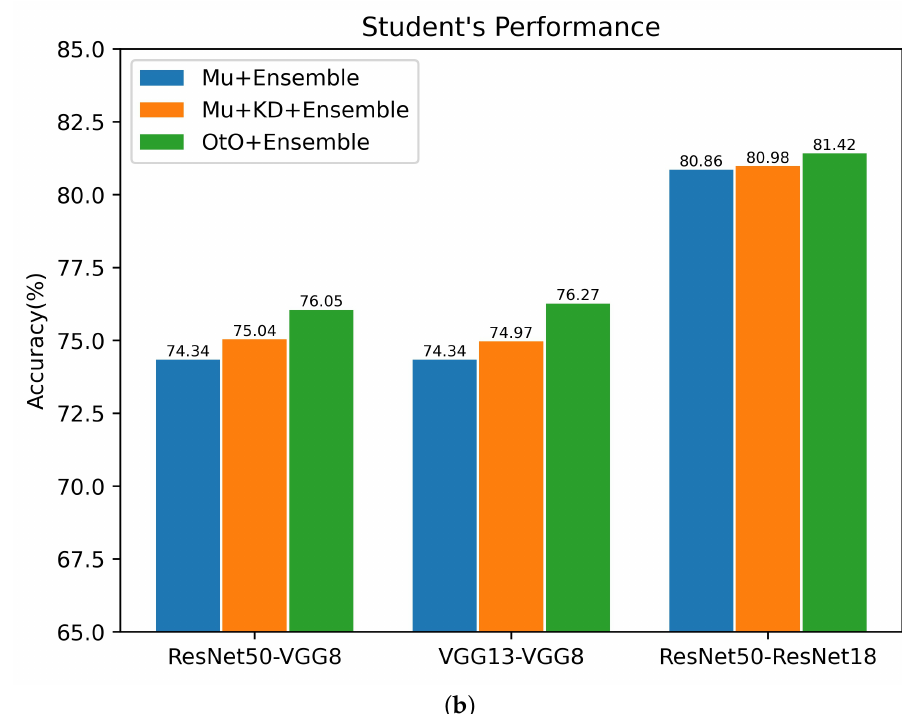
Figure 4. Ablation study of multiple teacher–student architectures for CIFAR100. The horizontal coordinate refers to the teacher–student architectures. ( a ) Accuracy of the final exit corresponding to different training methods. ( b ) Accuracy after the ensemble of multiple exits corresponding to different training